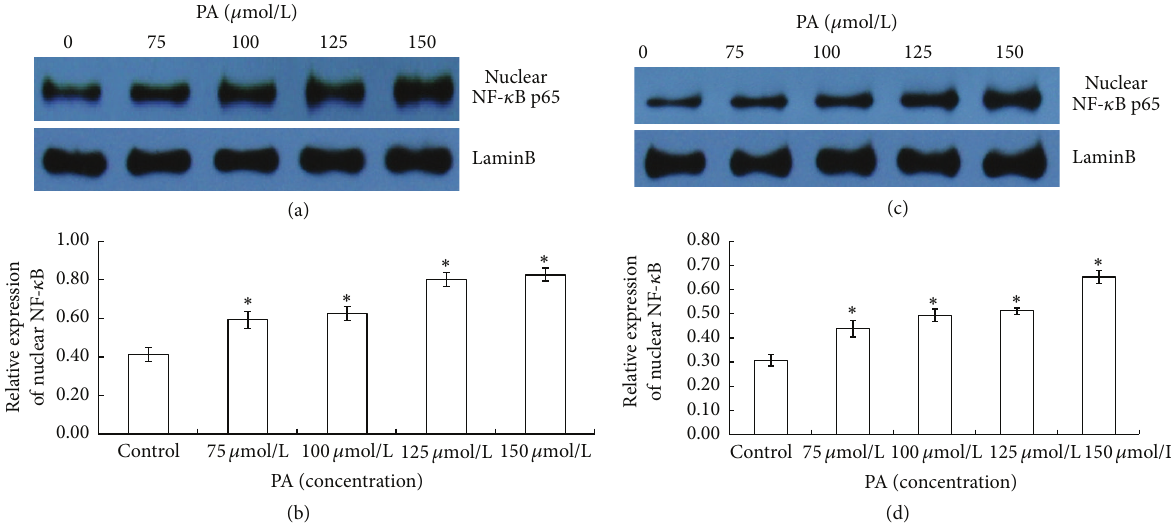
Figure 3: PA induces nuclear translocation of NF- 𝜅 B p65 subunit in HaCaT cells measured by western blotting. Keratinocytes were untreated or treated with PA (75, 100, 125, and 150 𝜇 mol/L) for 24 hours under serum-free conditions. The cells were harvested, and nuclear extracts were analyzed with NF- 𝜅 B p65 by western blot immediately after the treatment (a) and 24 hours after the PA depletion (c). The densitometry values are means ± SD of three independent experiments ((b) and (d)). Asterisks ( ∗ ) indicate significant differences of 𝑃 < 0.05 , respectively, between the PA-treated groups and nontreated